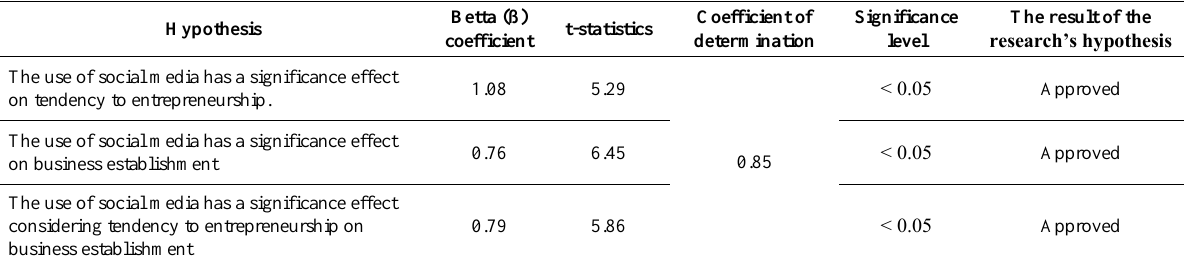
Table 2. Ratio coefficient, t statistic and result of research's